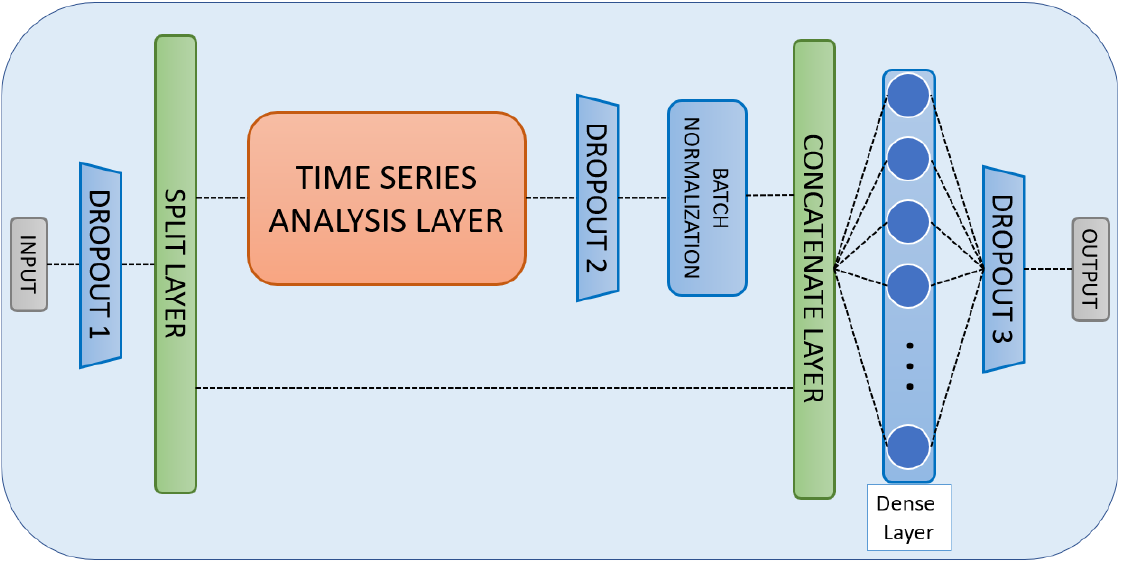
Figure 8. Neural network architecture model for both